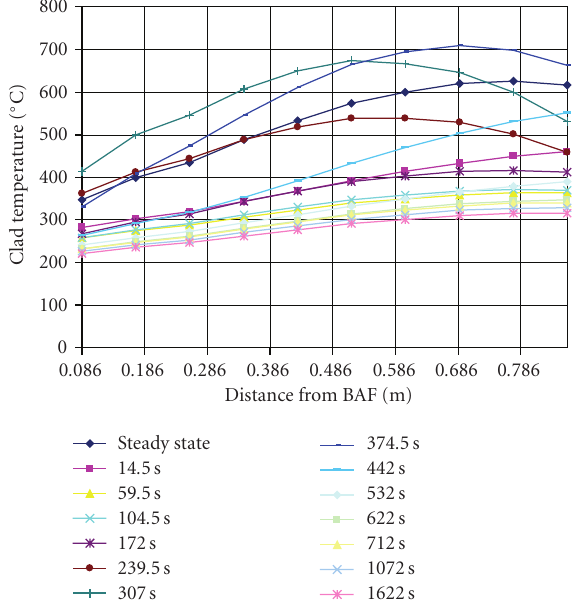
Figure 12: Temperature axial profile—LOFA—Average Channel.